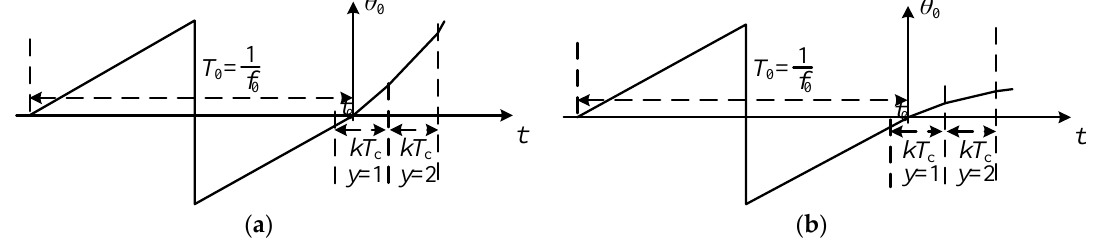
Figure 2. Change of the phase angle after the inverter is disconnected from the grid. ( a ) The disturbance tending to increase the current frequency. ( b ) The disturbance tending to decrease the current frequency.